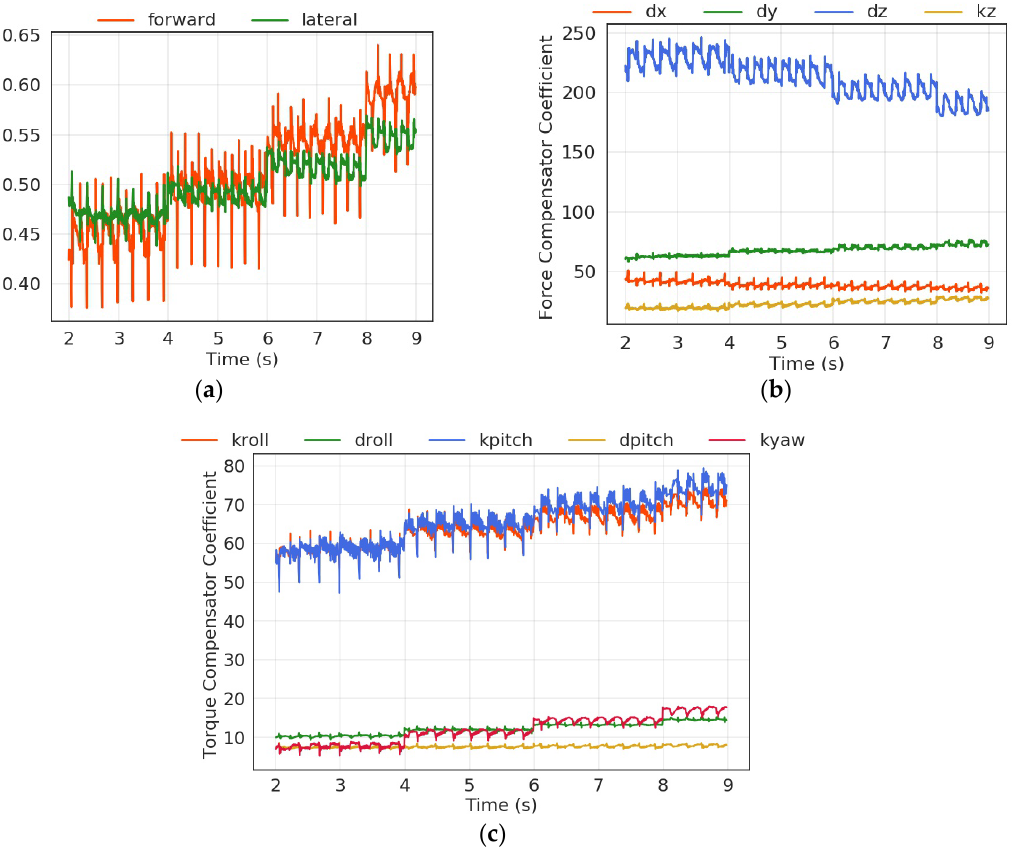
Figure 11. The adaptive variation of parameters during the acceleration of the quadruped robot. ( a ) Parameters for swing planner; ( b ) Parameters for force compensator; ( c ) Parameters for torque compensator.